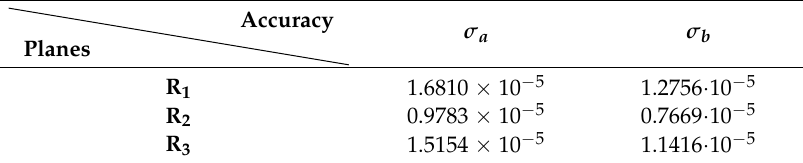
Table 3. Accuracy of the parameters of the equations of the planes.